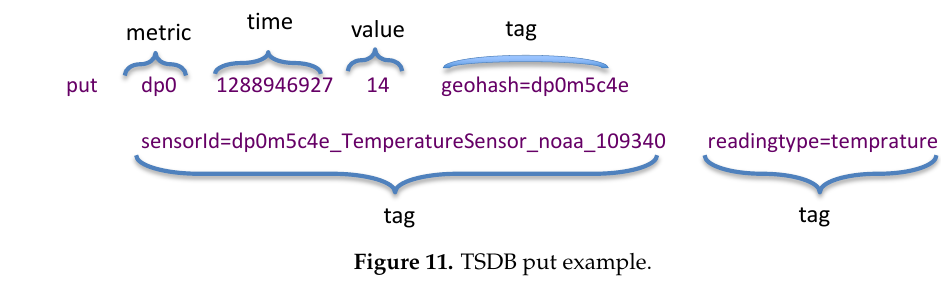
Figure 11. TSDB put